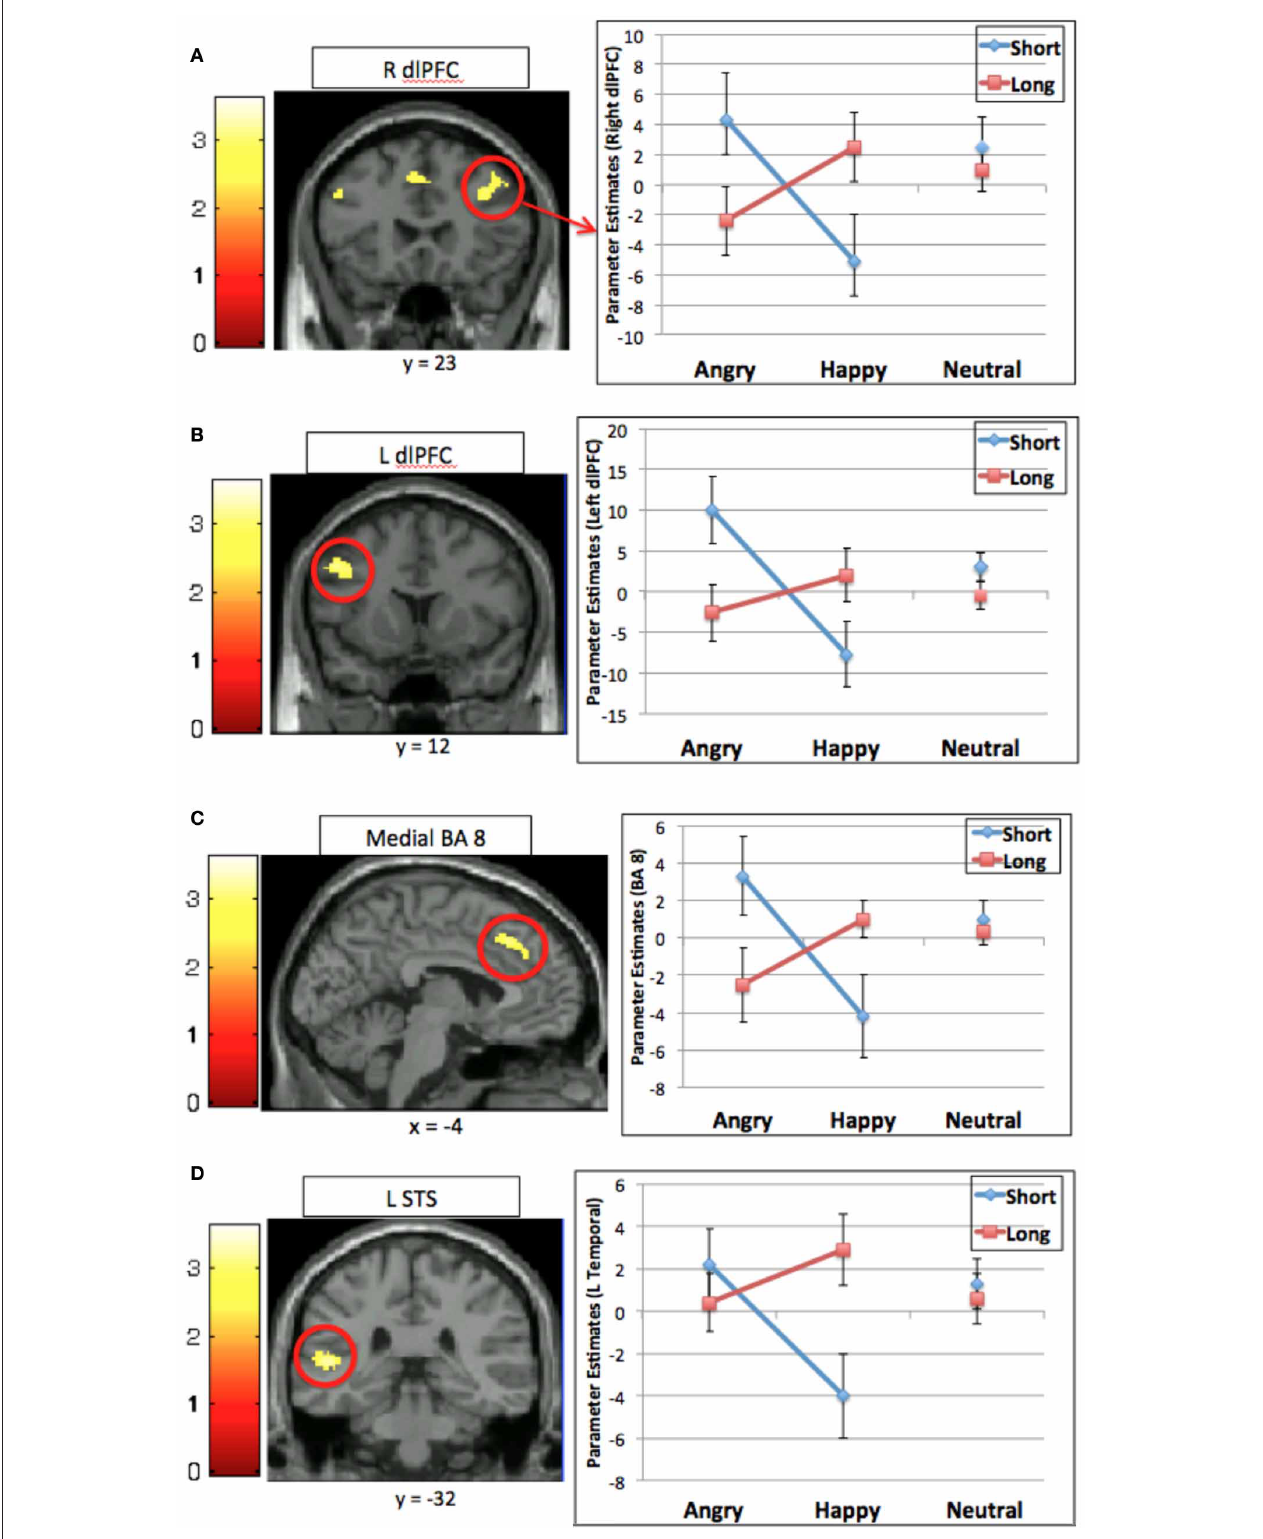
FIGURE 2 | Interaction between emotional valence and 5-HTTLPR for the interference contrast (incongruent > congruent) in four regions: (A) right dorsal lateral prefrontal cortex (R dlPFC); (B) left dorsal lateral prefrontal